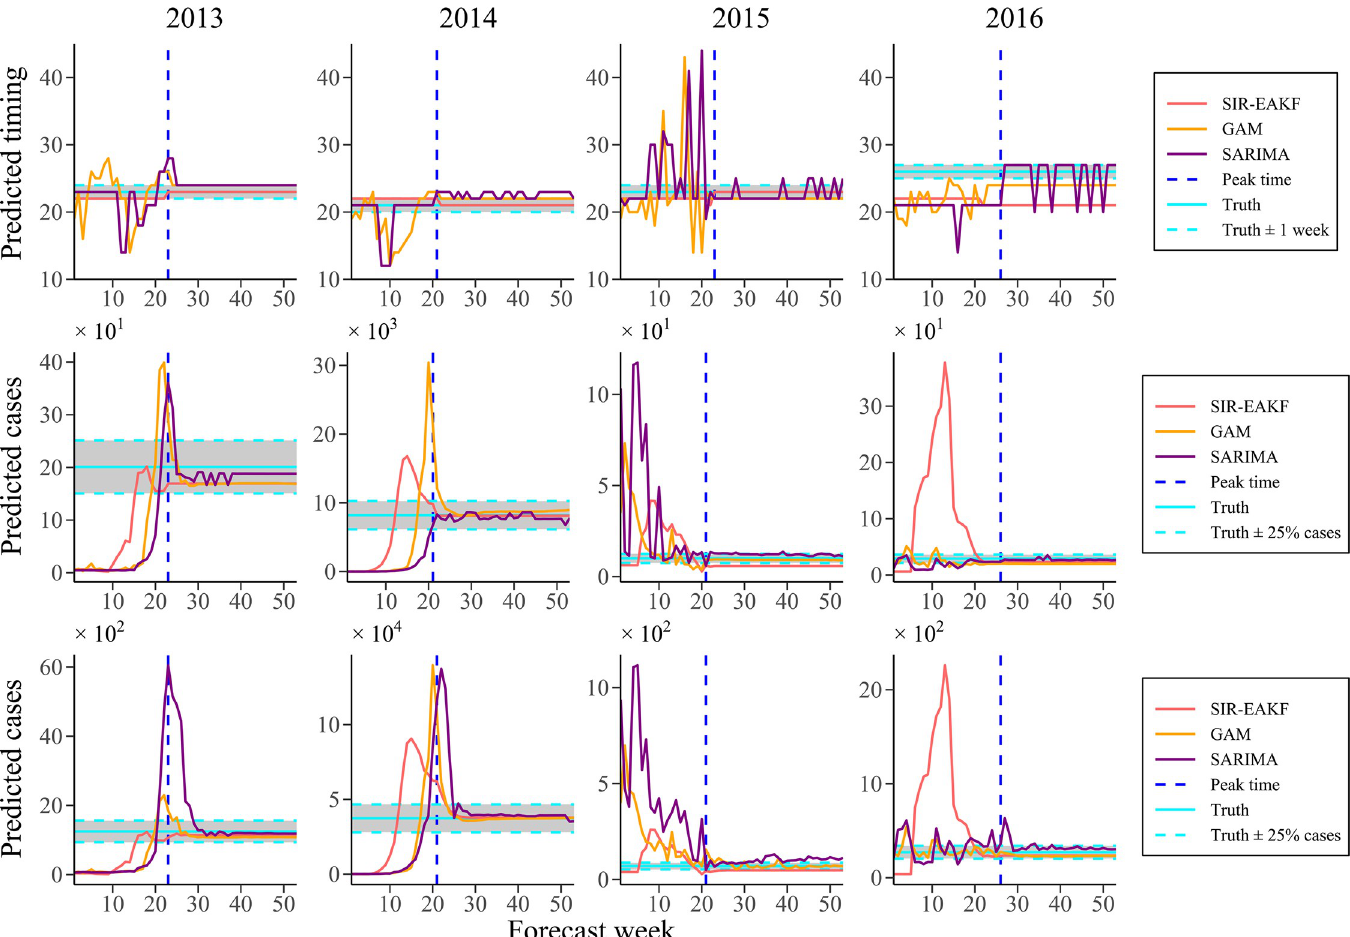
Fig 7. Comparison of the combined SIR-EAKF with the benchmark models in terms of several prediction targets (peak time, peak intensity and total incidence) from the seasons of 2013–2014 to those of 2016–2017. The peak time, peak intensity and total incidence are shown in sequence from top to bottom. The true index (horizontal light blue solid line) and its accuracy interval (horizontal light blue dotted line; ± 1 week / ± 25% cases of the observed) and the observed peak (vertical royal blue dotted line) were also shown. Note that combined SIR-EAKF forecasts (red), GAM forecasts (golden) and SARIMA forecasts (purple) to the left of vertical line were made prior to the peak and forecasts to the right were made after the true peak had